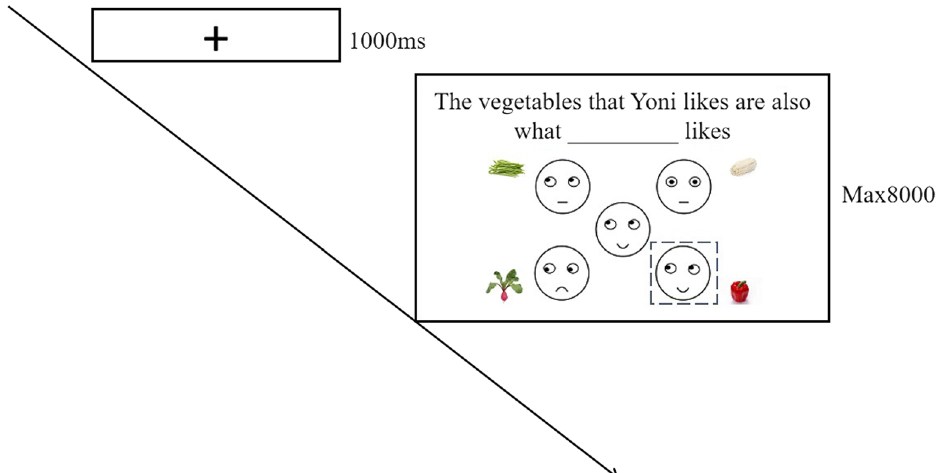
Fig. 3 Flowchart of a single trial of Yoni task. Note . For the convenience of reading, we have dotted the correct